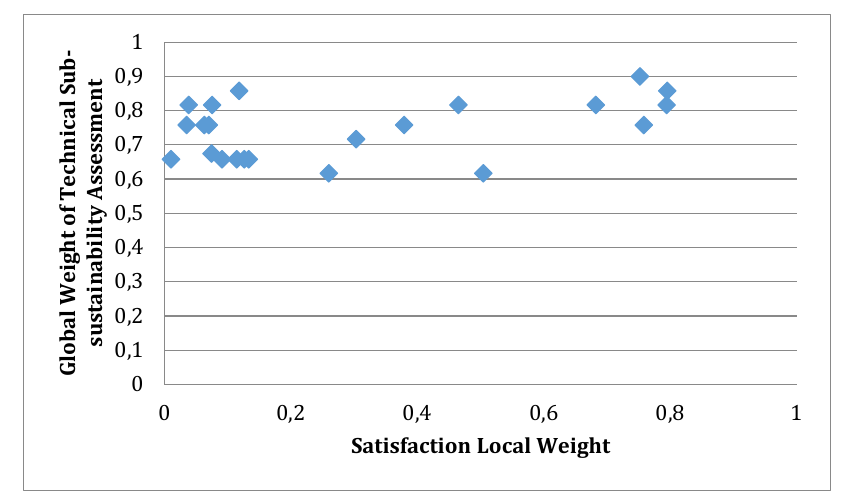
Figure 31: Global weight vs. satisfaction local weight of technical sub-sustainability assessment